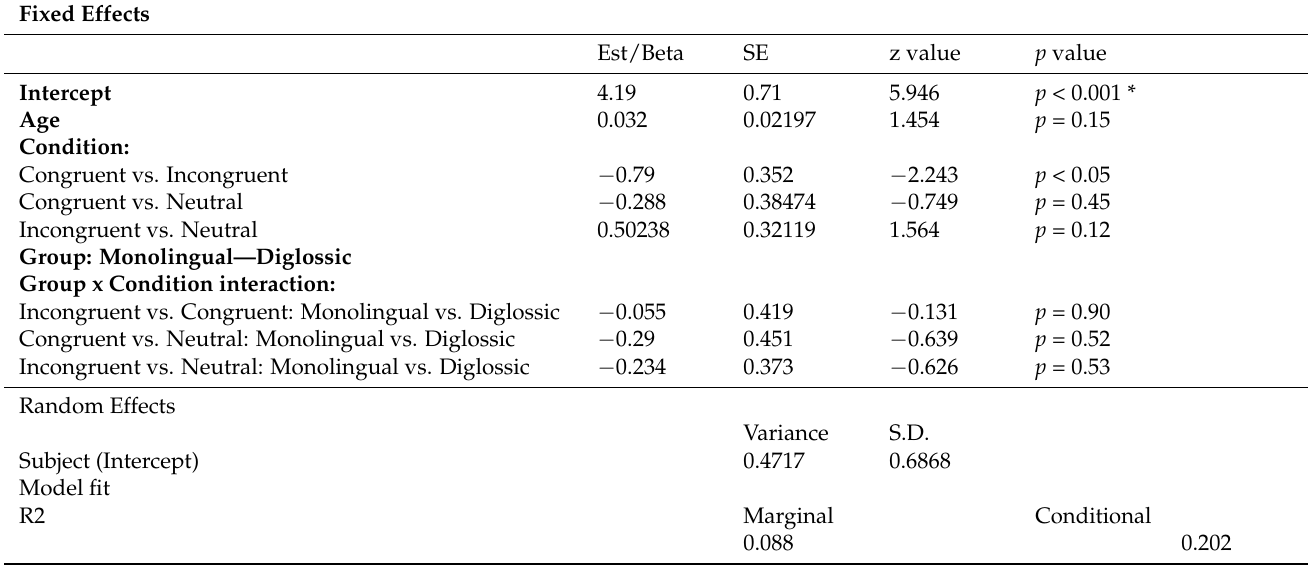
Table 3. Accuracy results for the Stroop task.